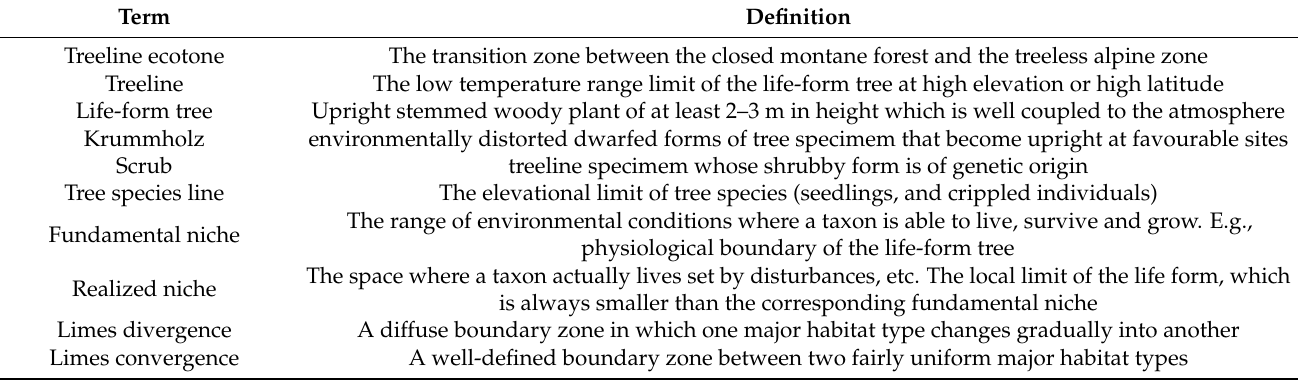
Table 1. Definitions and nomenclature used in discussing the nature of the alpine treeline. Compiled and modified after